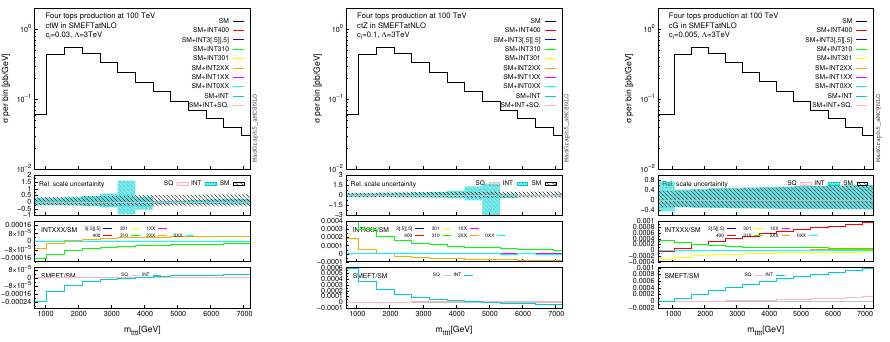
Figure 25 . Same as figure 14 but for the rest of the contributing two-fermion and purely-bosonic